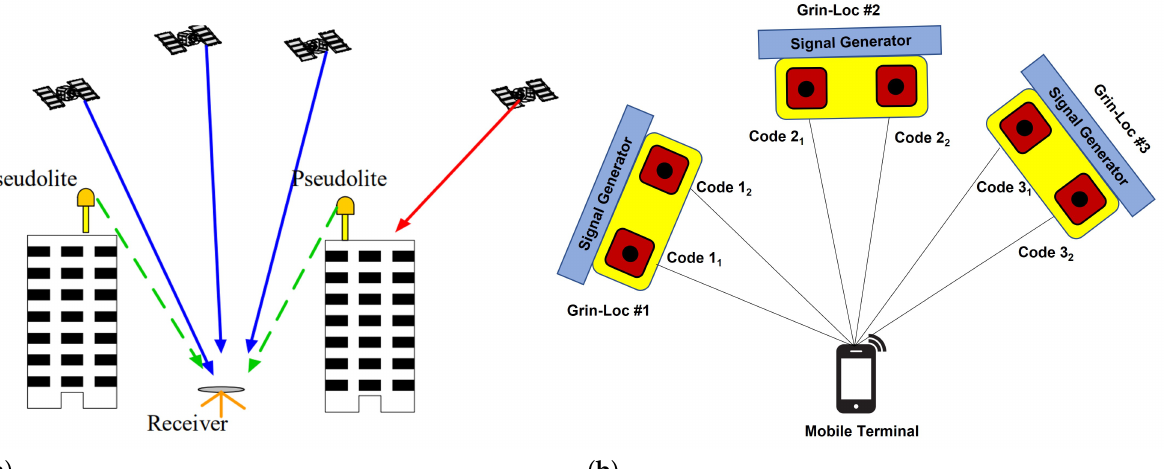
Figure 13. Indoor GNSS Satellites: ( a ) Pseudolites reproduced with permission from Fang-Shii Ning, Preliminary Testing of Pseudolite to Improve GPS Precision , published by ResearchGate, 2004, and ( b ) Grin-Locs-based positioning system, reproduced with permission from Samama, A GNSS-based Inverted Radar for Carrier Phase Absolute Indoor Positioning Purposes , published by IEEE,